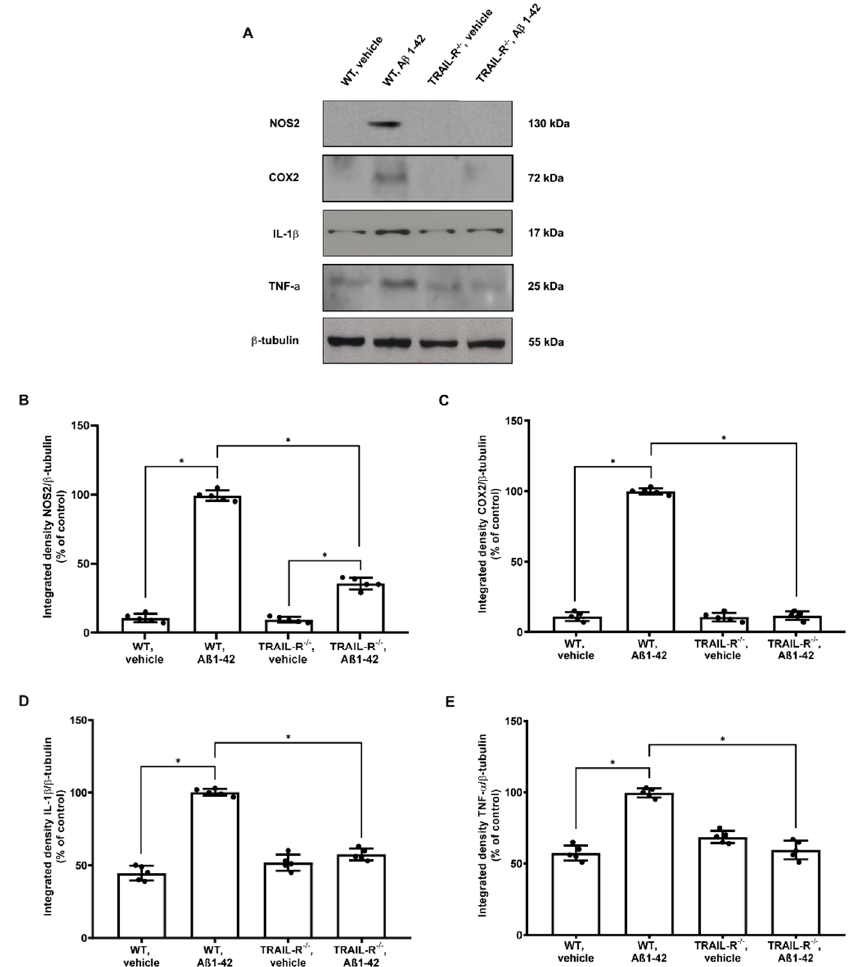
Figure 8. Inflammatory molecules expression is attenuated in TRAIL-R − / − mice treated with A β 1-42. ( A ) Western blot analysis of NOS2, COX2, IL-1 β and TNF- α in WT and TRAIL-R − / − mice following stereotaxic infusion of oligomeric A β 1-42 or vehicle. ( B – E ) Densitometric analysis of western blots. Data are expressed as means ± SEM. One-way ANOVA and the Bonferroni post-hoc test were used to determine statistical significance. * p < 0.05. N = 5 animals for each